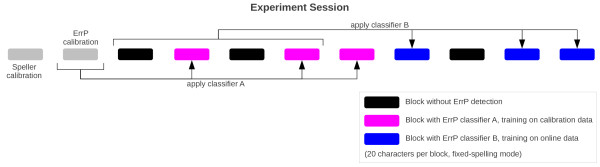
Session Design. In total, the experiment consists of 11 blocks. First, the Center Speller is run in offline mode (18 characters), then the ErrP Calibration Speller is run in fixed-spelling mode (83 characters). These two blocks (gray) are used to train the spelling classifier and the ErrP classifier A, respectively. Subsequently, 4 Center Speller blocks are performed in fixed-spelling mode (20 characters per block), and the data is used to train ErrP classifier B. Then the last 5 Center Speller blocks are performed. The three different conditions have been interleaved during the 9 blocks: spelling without ErrP detection (black), spelling with ErrP detection using ErrP classifier A (magenta) and spelling with ErrP detection using ErrP classifier B (blue).